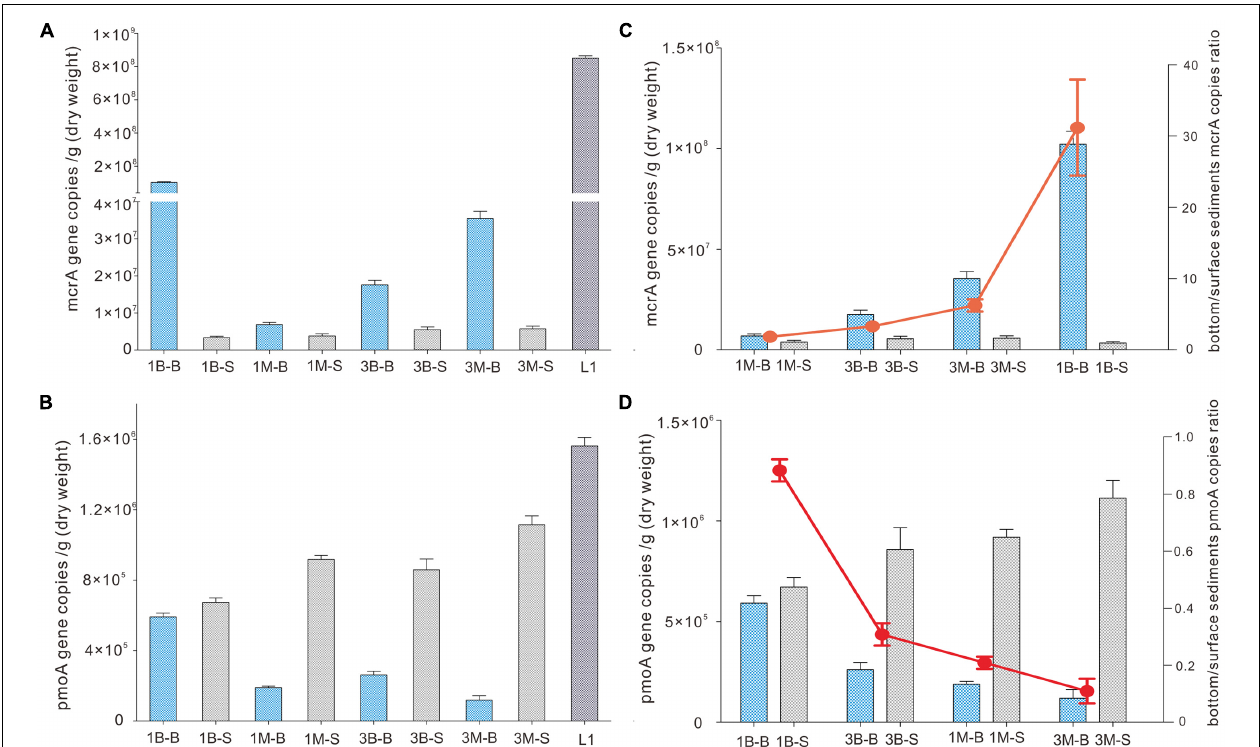
FIGURE 2 |Abundance of mcrA gene (A) and pmoA gene (B) of intertidal mudflat and mangrove sediment samples. Quantitative PCR gene copies in subsurface (bottom) and surface sediments are expressed in ratio as red dots (C,D) . Error bards are vertical lines as standard deviations of three independent